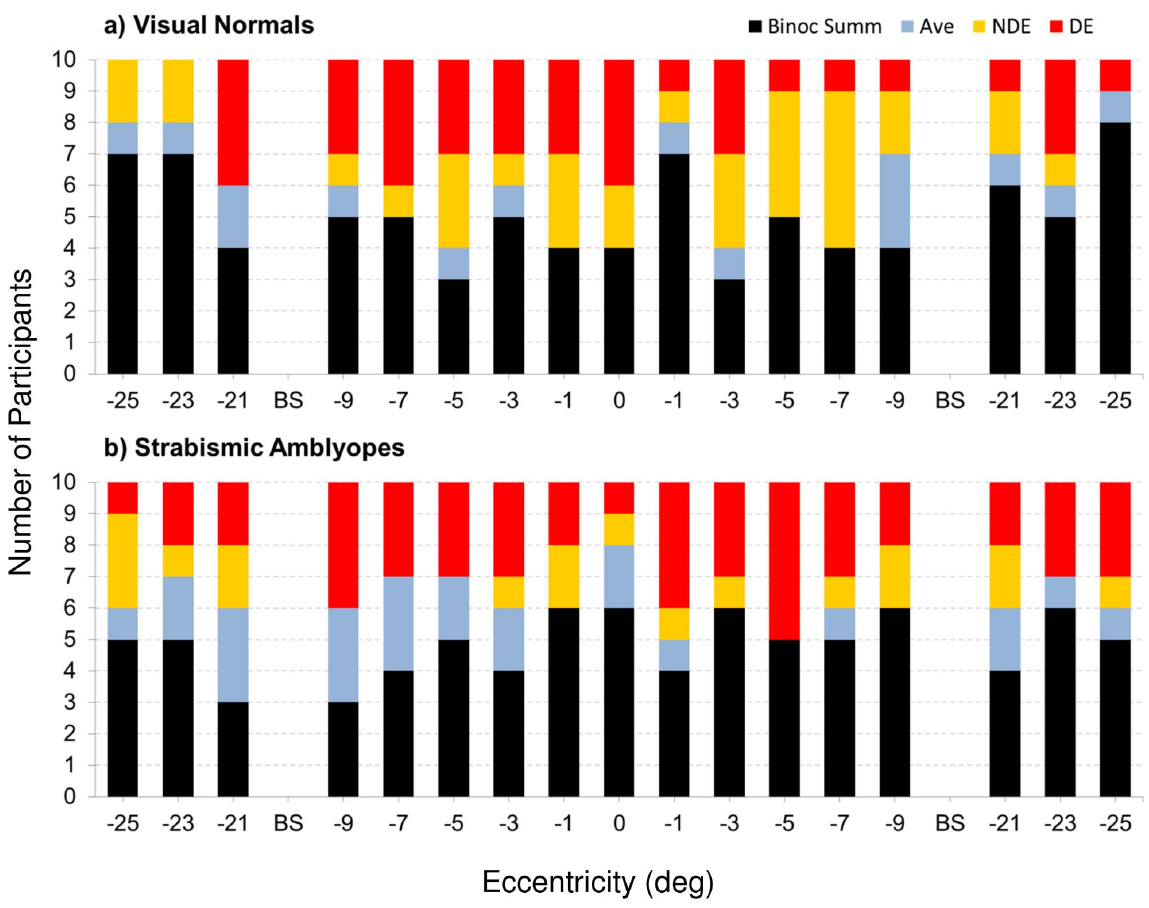
Figure 5. Summary of results obtained in visual normals (top, (a)) and in strabismic amblyopes (bottom, (b)). To account for the fact that in normals and strabismic amblyopes, the dominant eye may be the right or left eye, the results for some participants have been flipped so that the dominant eye is always the right eye, and the non-dominant eye is always the left eye . Locations corresponding to the blind spot (BS) in each eye were excluded from this analysis and are thus shown as gaps in the figure. Each bar corresponds to a visual field location in degrees to the left or right of the straight ahead position. The proportion of each bar that is black in colour indicates the proportion of normals (a) or strabismic amblyopes (b) for whom the binocular summation (Binoc Summ) model provided the closest estimate of binocular sensitivity actually exhibited at that field location. The proportion of individuals for whom the average monocular sensitivity is closest to binocular sensitivity is coded in blue (Ave), and red and yellow (NDE) colours represent the proportions where, respectively, the dominant (DE) and non-dominant (NDE) eye sensitivity is closest to the binocular sensitivity actually exhibited.